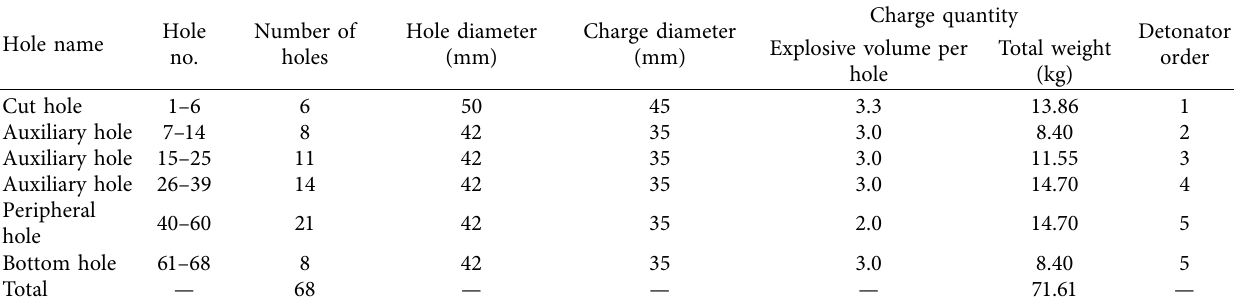
Table 8: Blasting parameters for cut blasting with a large diameter charge.